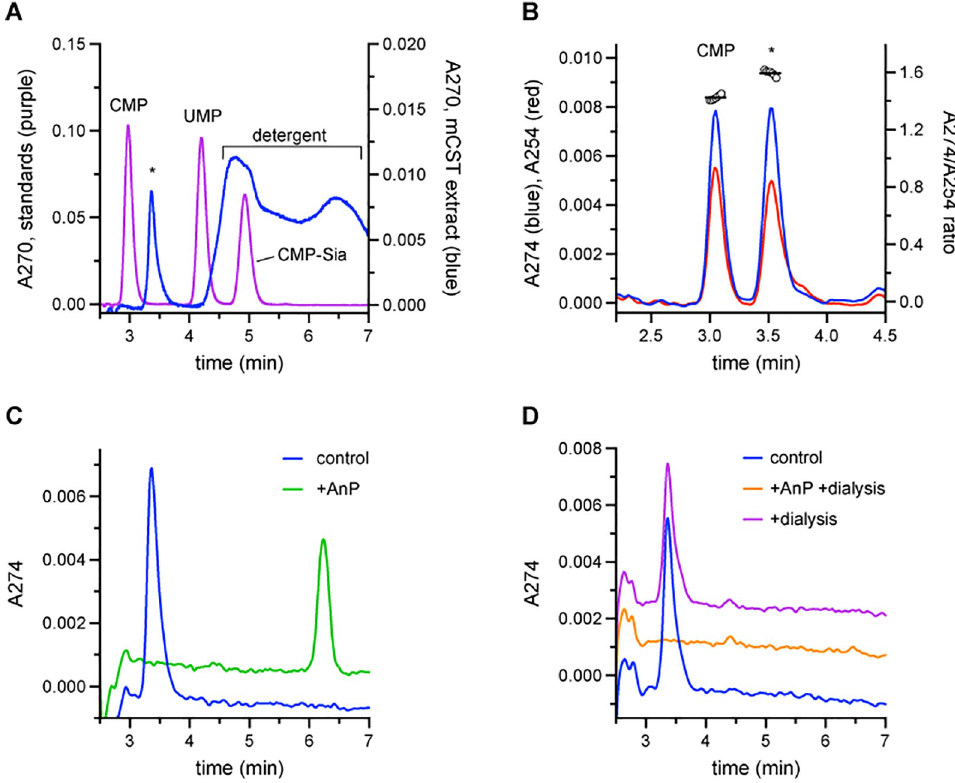
Fig 1. HPLC characterization of the molecule that co-purifies with CST. A) The aqueous layer of a phenol- chloroform extraction of purified CST was run on a C18 HPLC column (blue trace). The peak representing the unknown molecule is labeled with an ‘ � ’ and the broad peak representing residual detergent left in the extract is also labeled. A separate sample containing 50 μ M each of CMP, UMP, and CMP-Sia was also run (purple trace). Peaks corresponding to each standard are labeled. B) A sample of a phenol-chloroform extract of CST with an extra 2.5 μ M CMP added was run on a HPLC C18 column. Absorbance at 274 nm (blue trace) and 254 nm (red trace) was monitored. The ratio of the absorbance at these two wavelengths for a given time is plotted as the open circles on the right y-axis. The black horizontal lines represent the average A274/A254 ratio for the two peaks. C) A sample of a phenol-chloroform extract of CST was run on a C18 HPLC column after it had been incubated for 24 hr at 4˚C either with (green trace) or without AnP (blue trace). D) A phenol-chloroform extraction was performed on a CST sample immediately after purification (blue trace), after it had undergone 24 hr dialysis (purple trace), or after it had undergone 24 hr dialysis in the presence of AnP (orange trace). The extracts were then run on C18 HPLC column. The traces in panels C and D are arbitrarily separated by either 0.001 (panel C) or 0.002 (panel D) units along the y-axis to improve